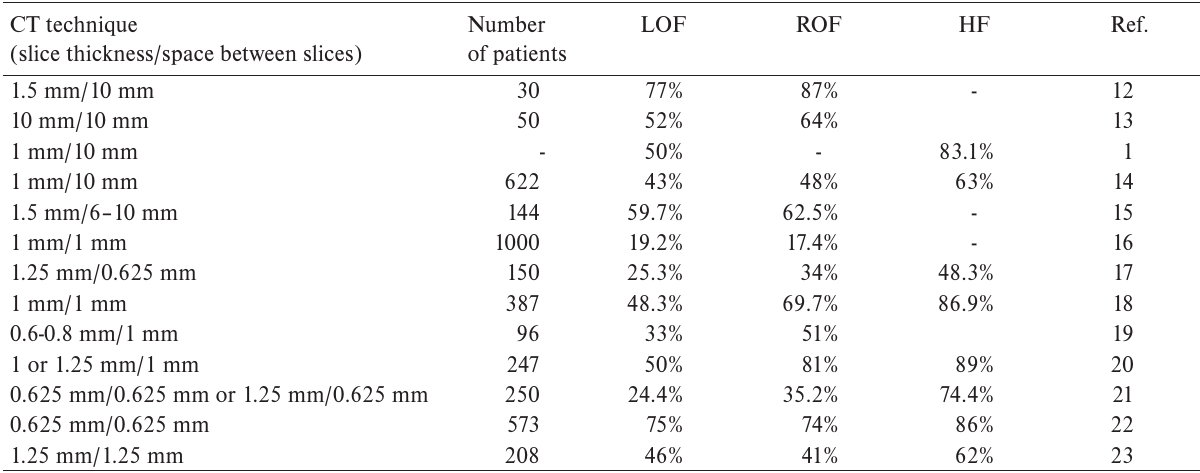
Table 1. Frequencies of incomplete fissures on CT.